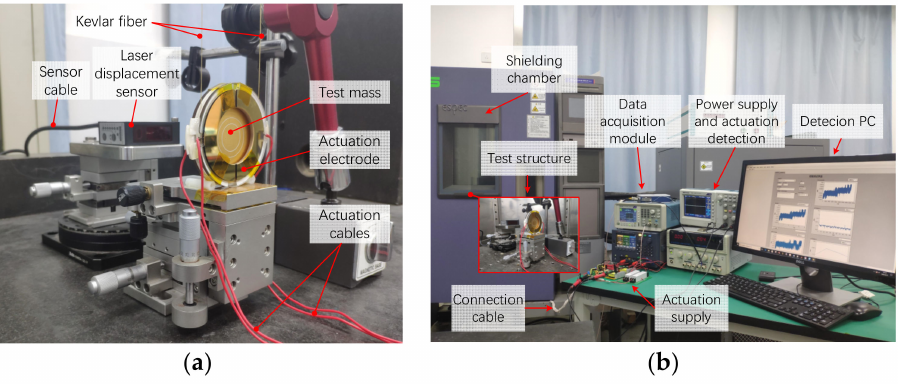
Figure 18. Testing structure for electrostatic force measurement: ( a ) The suspended pendulum and optical sensor fixed on motivation platform. ( b ) Set-up of force measurement